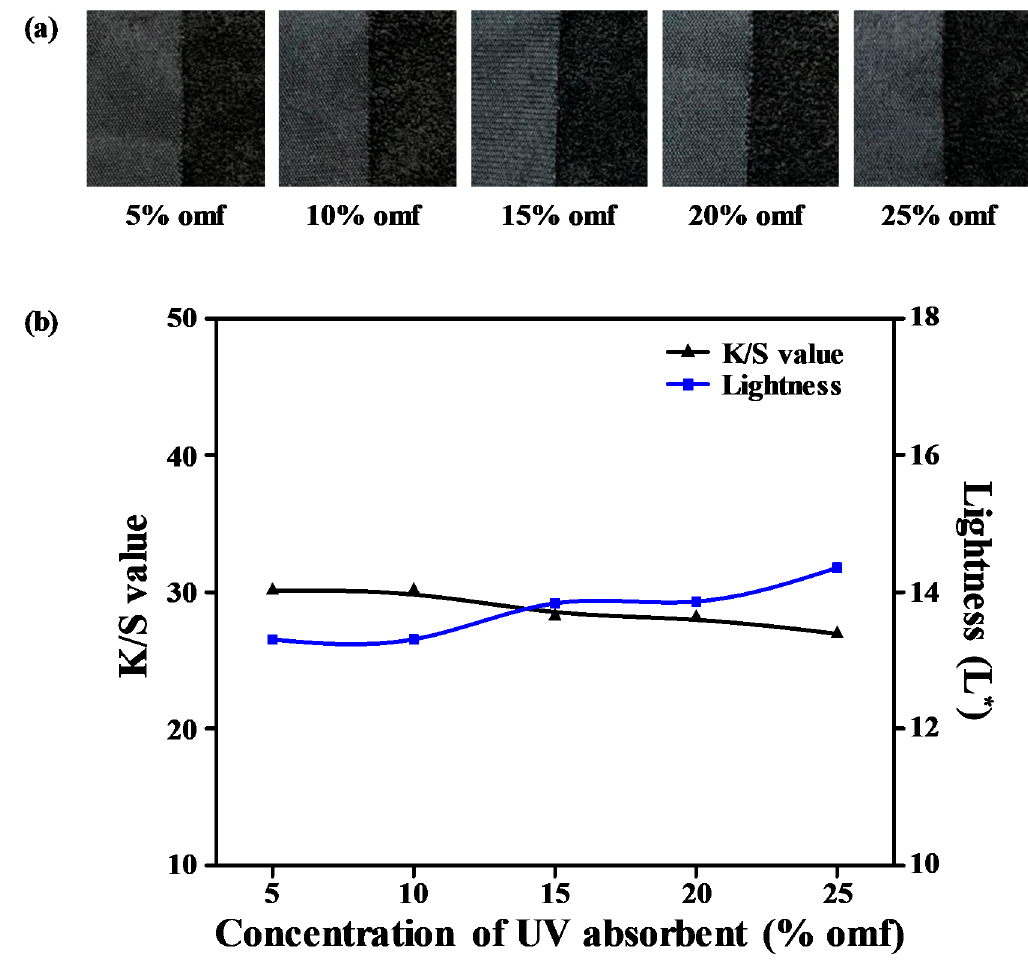
Figure 9. ( a ) Dyed samples. ( b ) K / S and lightness (L*) values according to UV absorbent concentration (5%–25% omf).